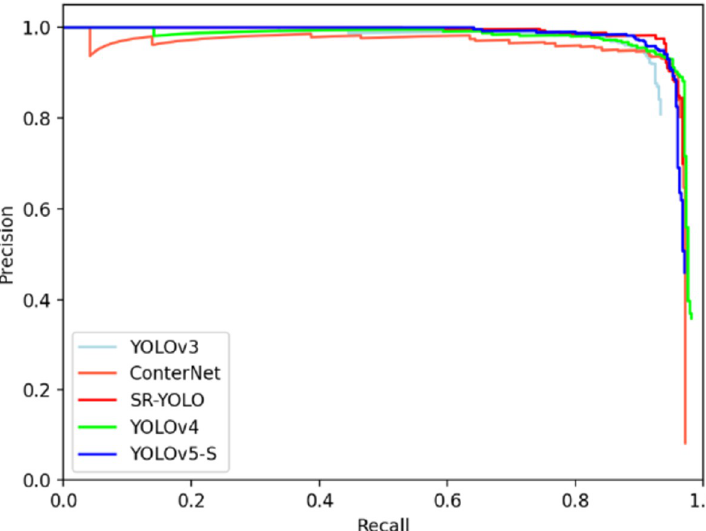
Fig 9. The AP curve of the algorithm in this paper and the current most advanced